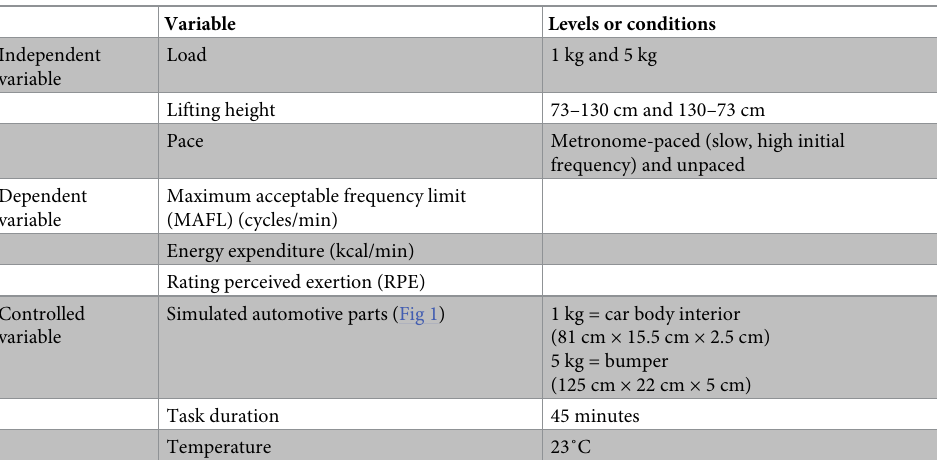
Table 2. Variables and conditions of the experiment.